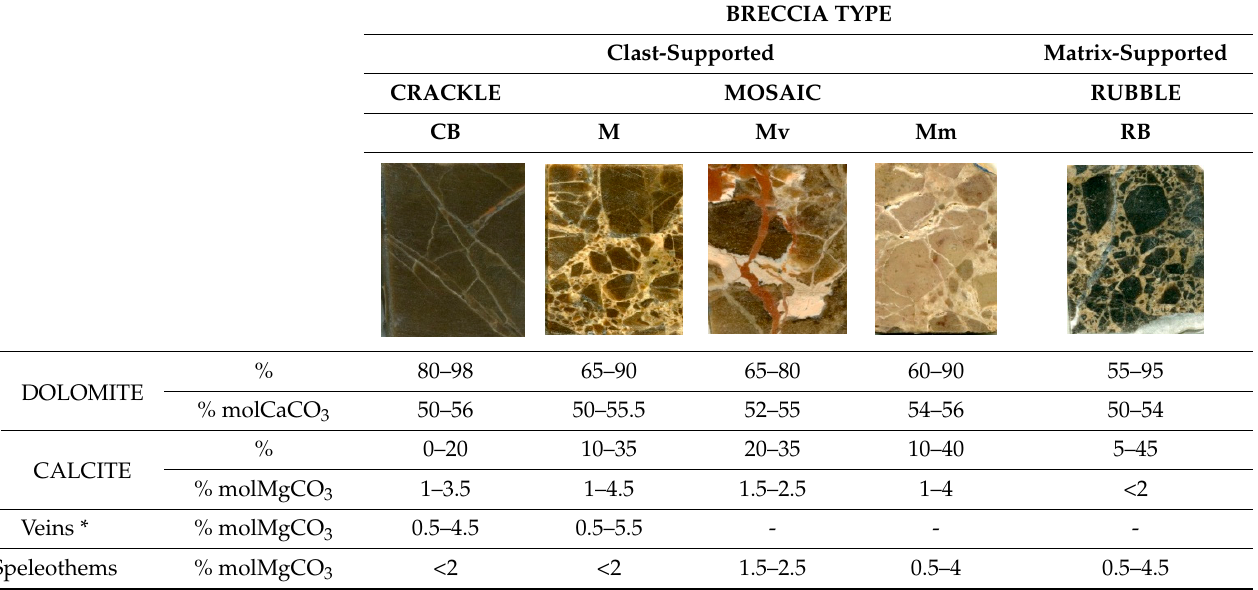
Figure 6. Degree of ordering of the analysed samples. Order ((I (015)/I (110)) vs. stoichiometry (% molCaCO 3 ). Regarding the degree of ordering of the dolomites, a direct relationship with their stoichiometry is not observed (Figure 7). The main recognised breccia types show the same variability in the degree of ordering (Figure 6), it can only be noted that the dolosparitic mosaics associated with the “crackle” breccias appear less ordered.